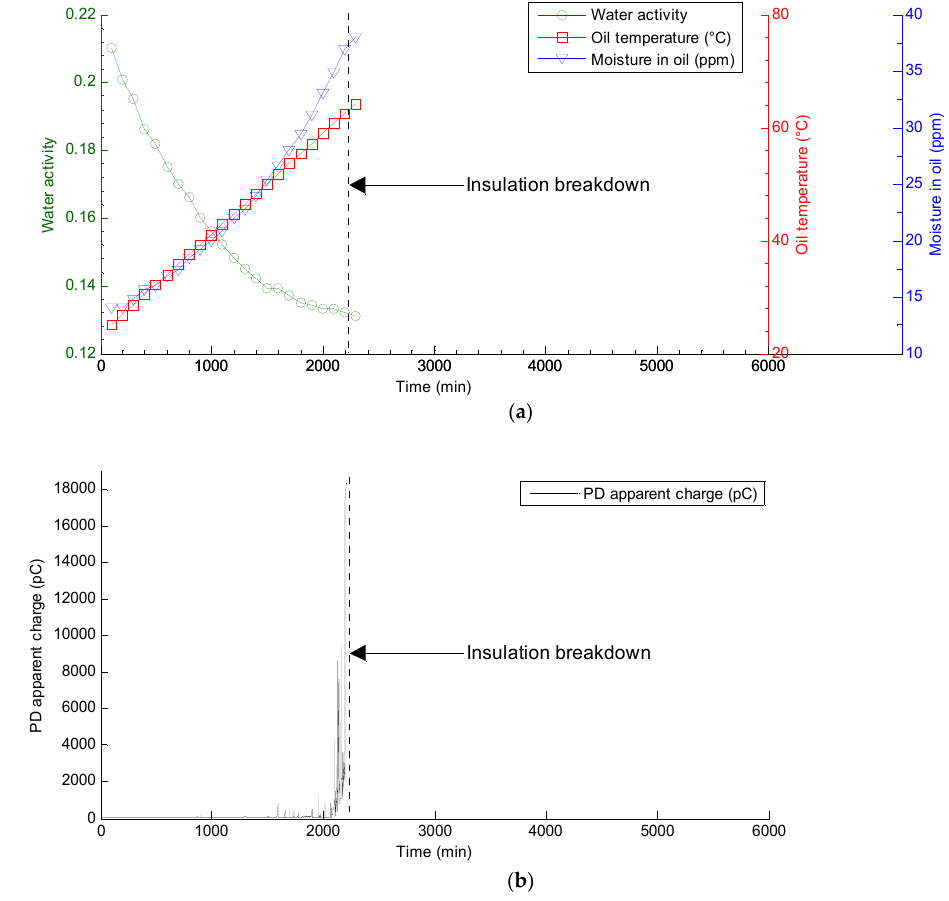
Figure 11. Typical experimental results obtained for an insulation sample with a moisture content of 5.7%: ( a ) water activity, temperature and moisture content of oil; and ( b ) PD apparent charge.